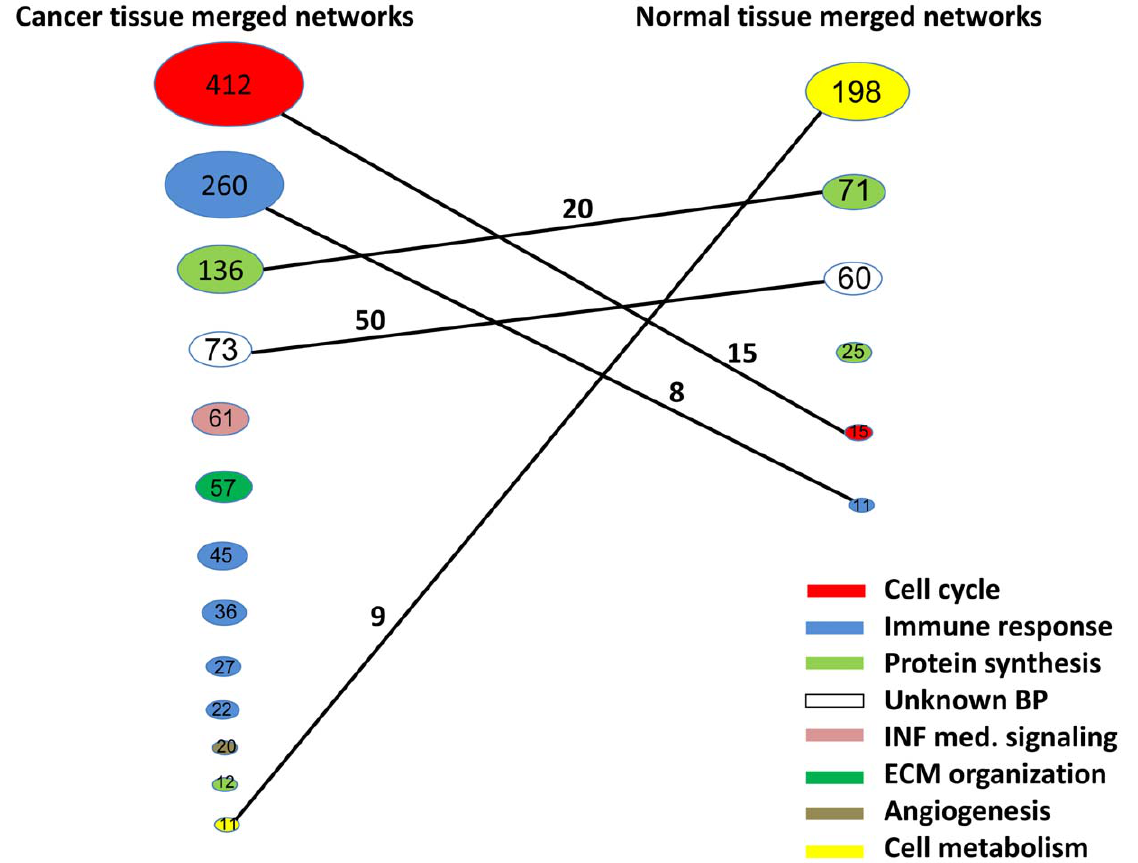
Figure 2. Comparison of networks identified from multiple cancer vs. normal tissue microarray datasets. Top 13 networks (ranked by size) were shown. The size of each circle represents the relative size of each network. The numbers inside the circles indicate the size of the network. The numbers above the connection line indicate the numbers of common genes shared by the two networks. Different top-enriched biological functions in each network were assigned with different colors. ECM: extracellular matrix construction. Parameter settings are: b =0.8, c =0.8, l =2.0, t=1.0 (for networks from cancer datasets); b =0.8, c =0.7, l =2.0, t=1.0 (for networks from normal tissue datasets).